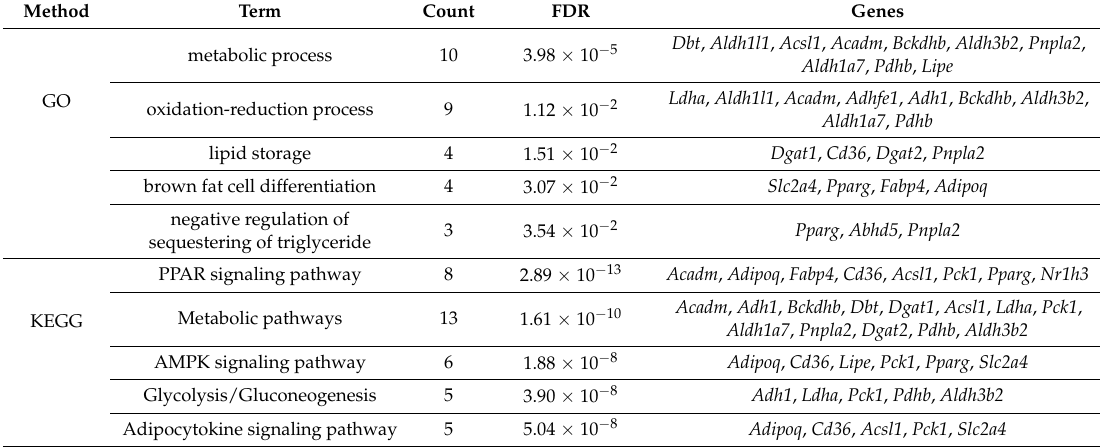
Table 5. Enrichment analysis of the top 30 genes with the highest